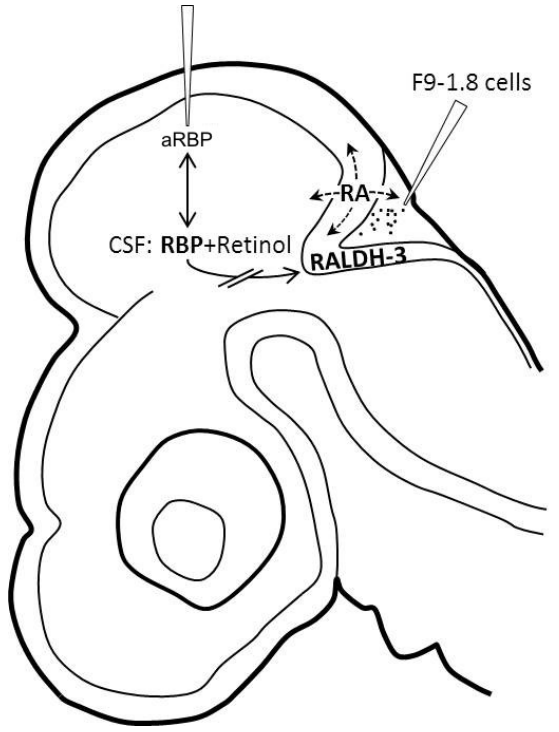
Figure 1. Diagram of a saggital section of an early embryo cephalic end, showing the experimental approach used in this study. On the left, microinjection into the embryonic brain cavity of Retinol Binding Protein Antibody (aRBP) to block the Retinol uptake in mesencephalic-rombencephalic isthmus (IsO) RALDH positive cells. On the right, simultaneous microinjection F9-1.8 cells into the mesenchyme of